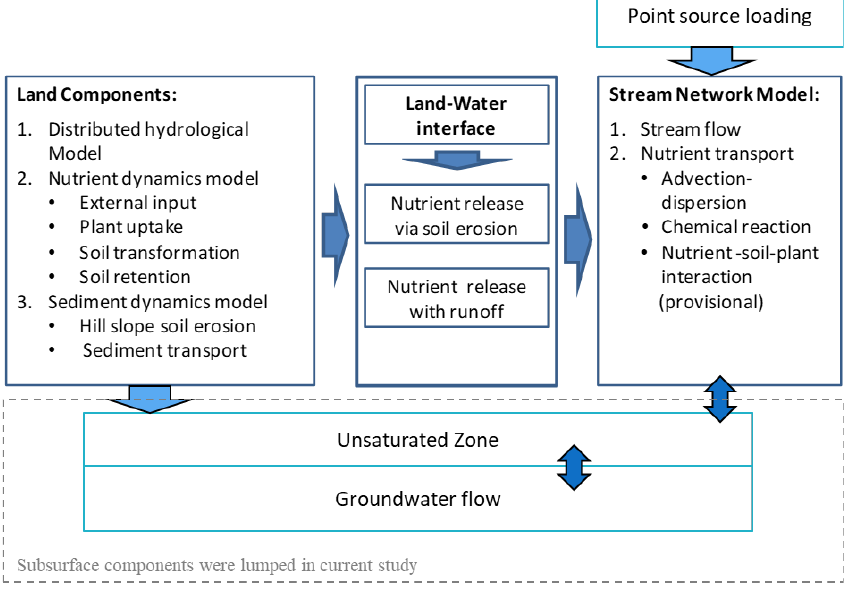
Figure 1. Integrated modelling framework for nutrient dynamics and transport.